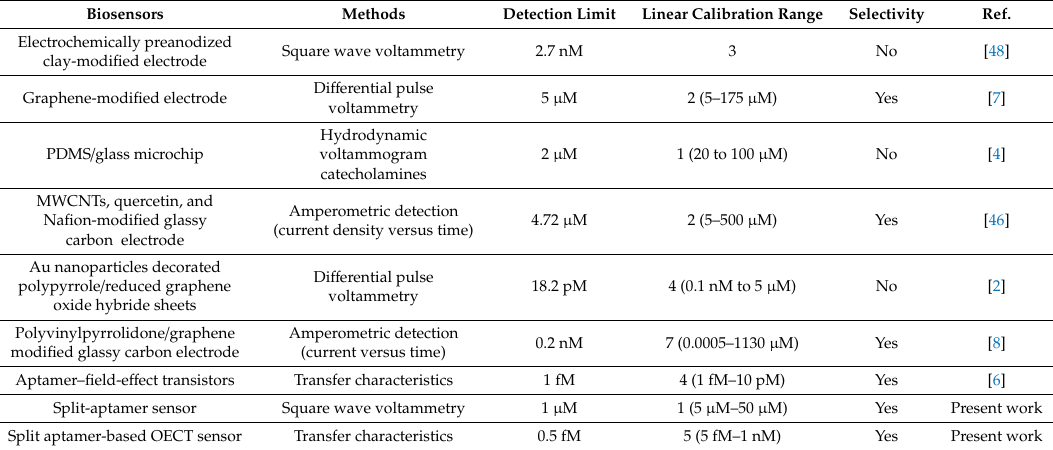
Figure 4. Transfer characteristics of flexible interdigitated organic electrochemical transistors (iOECTs) versus gate voltage at V ds = − 50 mV measured in 10 mM Tris buffer containing 0.5 μ M aptamer2 before and after the administration of different concentrations of the dopamine target. The target incubation time was 10 min. The concentration of dopamine in the Tris buffer was ( a ) 0.5 fM and ( b ) varying from 0 pM to 10 nM. ( c ) The logarithmic dependence between the shift in gate potentials ( Δ V gs ) and target concentrations. Table 1. Comparison of different types of biosensors for dopamine detection.